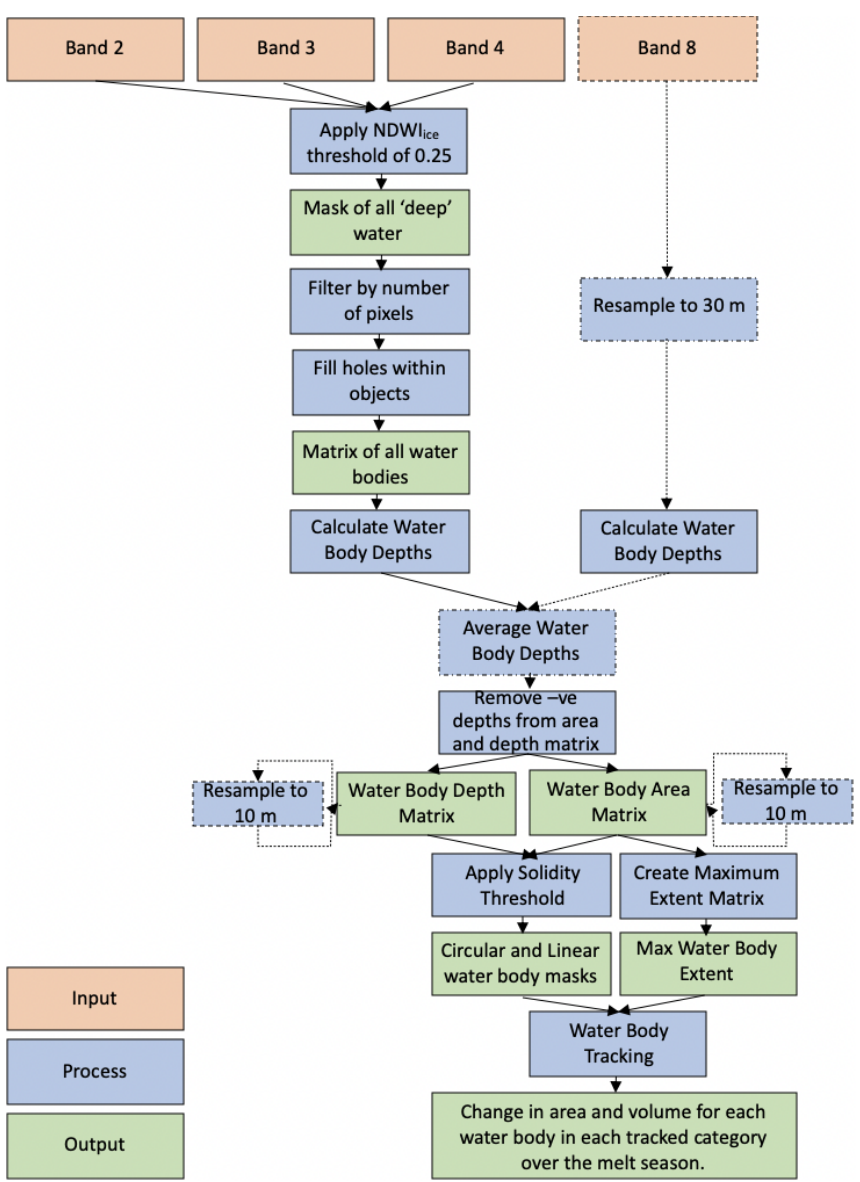
Figure 2. Workflow detailing the methods applied to both the Landsat 8 and Sentinel-2 images through the FASTISh algorithm in MATLAB. Dashed lines indicate steps that were applied to Landsat 8 images only, whereas solid lines indicate steps that were applied to both sets of image types. Modified from Williamson et al.